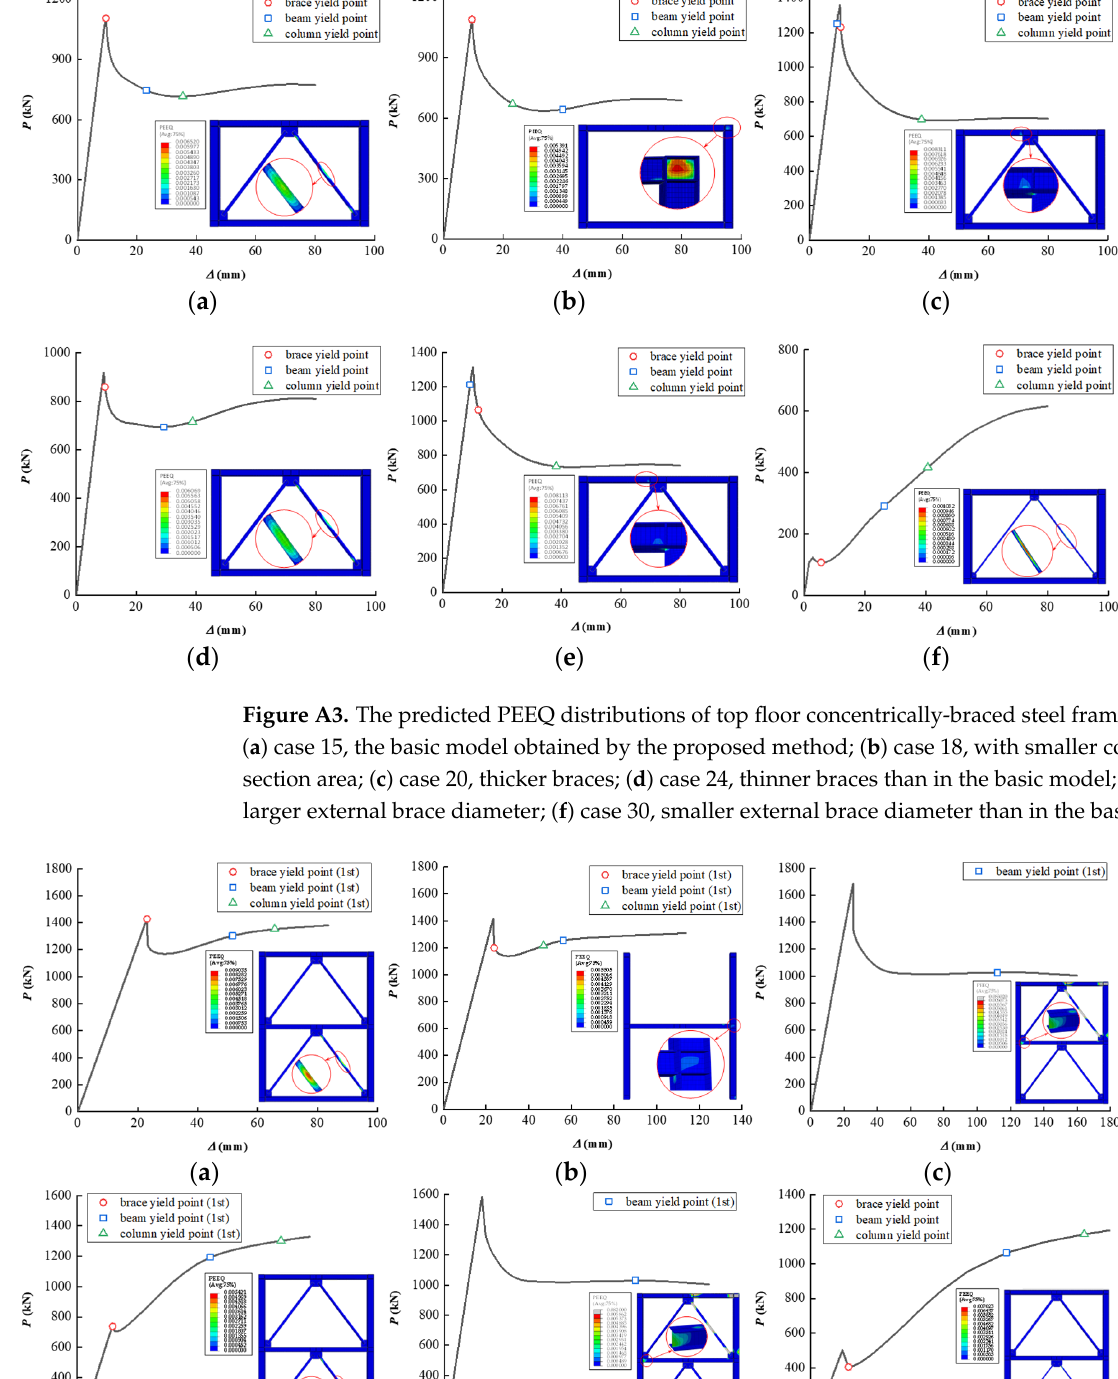
diameter than in the basic model; ( f ) case 29, smaller external diameter.